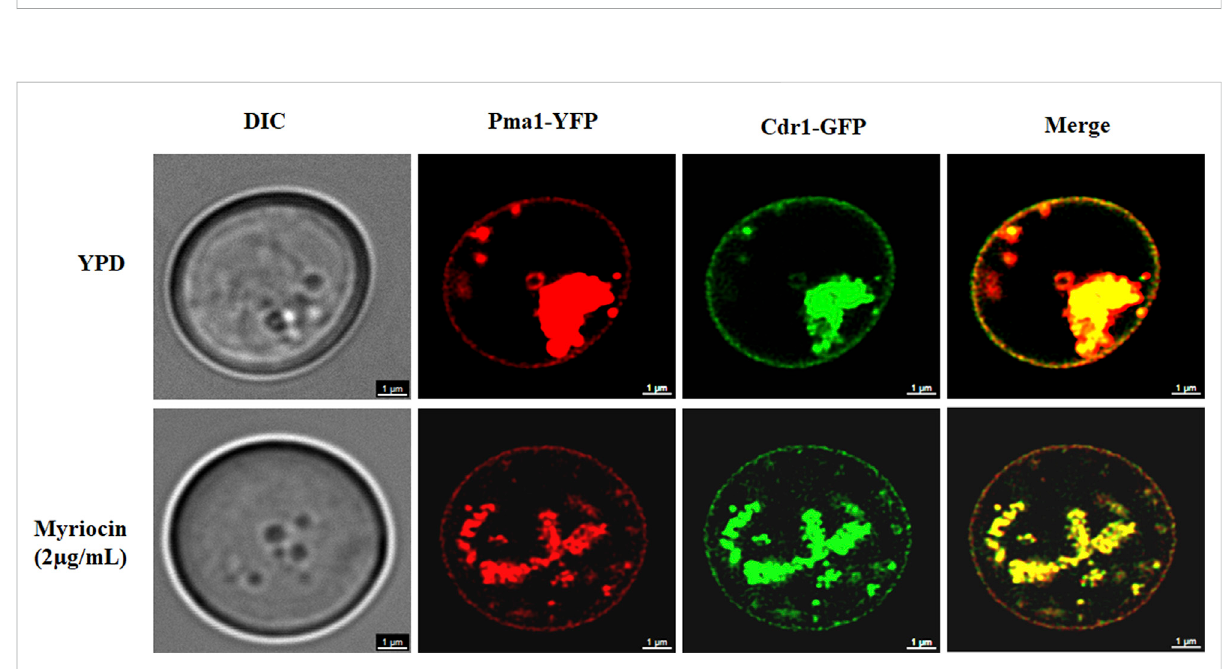
Confocal micrographs of cell membrane staining (Pma1-YFP) and membrane localization of Cdr1-GFP in the Cdr1-GFP:: Pma1-YFP mutant after treatment with or without 2 μ g/mL myriocin for 16 h in YPD medium. DIC, differential interference contrast; YFP, yellow fl uorescent protein; GFP, green fl uorescent protein. Scale bar = 1 μ